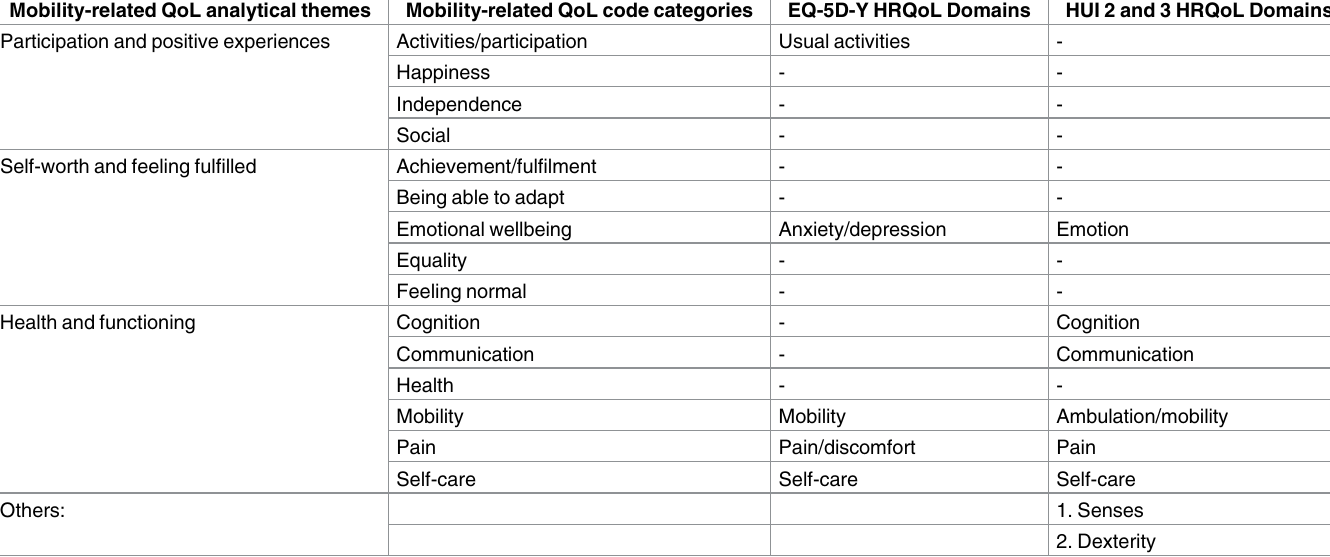
Table 3. Comparing domains of mobility-related QoL with HRQoL domains of the EQ-5D-Y and HUI. Mobility-related QoL analytical